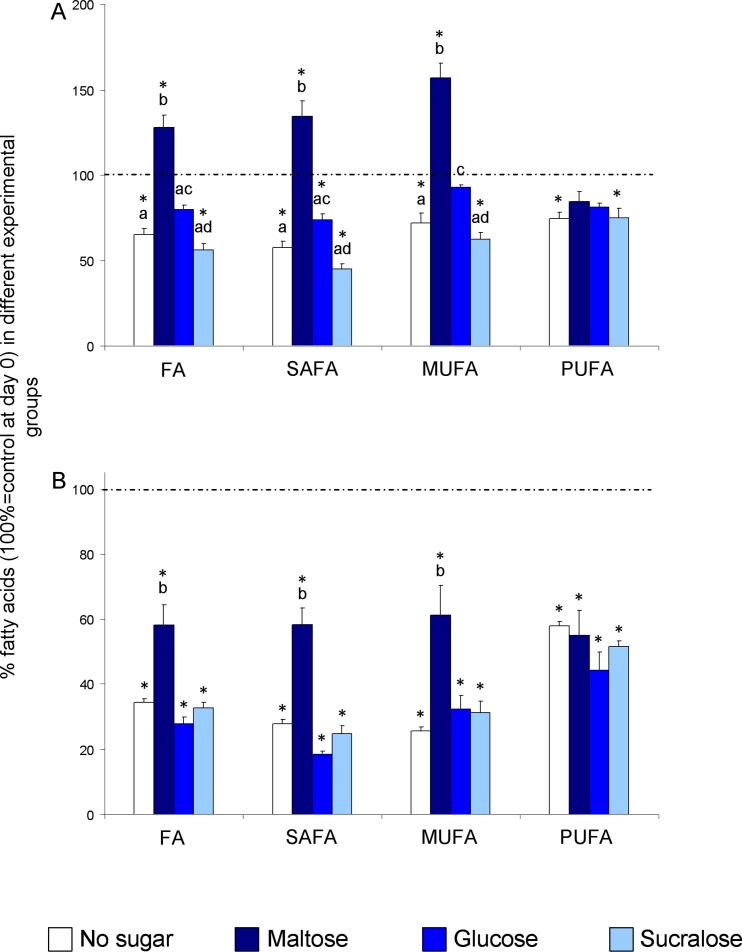
Metabolic results.Mean values ± s.e.m. of percentage of total FA, SAFA, MUFA and PUFA in experimental groups after feeding for 72h with different sugars (A) and fasting for 36h in alive flies (B). Asterisk indicates significant differences from the control (100% = day 0). Different letters indicate significant differences between sugars (P < 0.05; Tukey test or P < 0.05: Duncan’s test subsequent to one-way ANOVA).